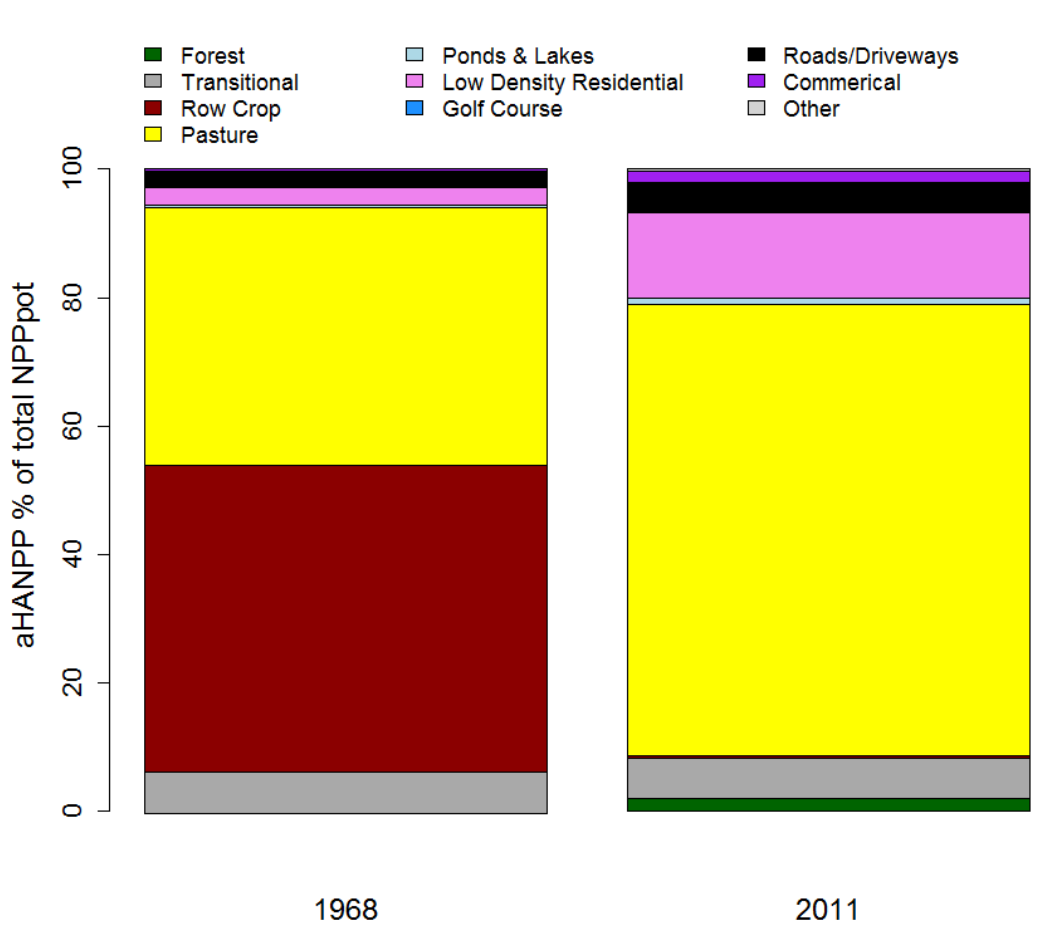
Figure 8. Aboveground HANPP percentage of total NPPpot in the Doddies Creek watershed for important land covers in 1968 and 2011. Aboveground HANPP for the entire watershed was 9.7 Gg·C·y − 1 ub 1968 and 9.0 Gg·C·y − 1 in 2011. A similar pattern of change was observed for total